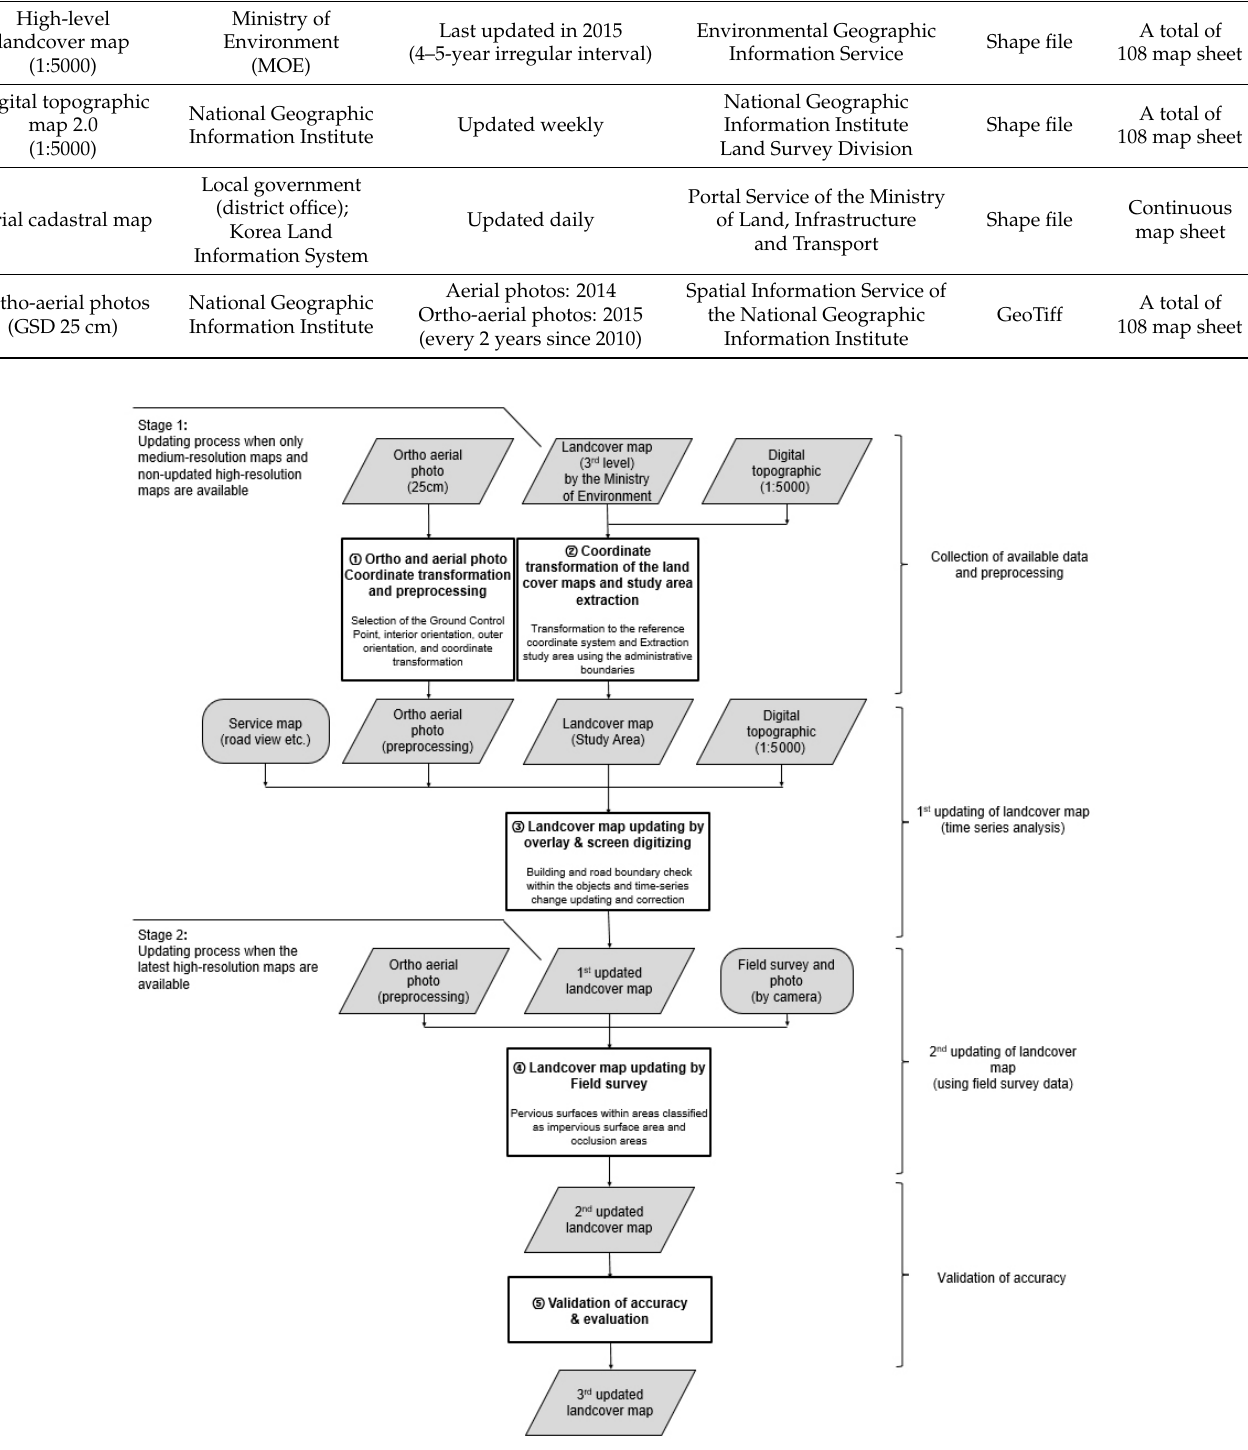
Figure 2. Flowchart of the proposed two-tiered detailed landcover map updating process. High-level landcover maps were available for Sejong City, allowing direct stage 2 processing. However, given that the maps were generated in 2015, some updates and corrections were performed in stage 1. As of 2017, high-level landcover maps are